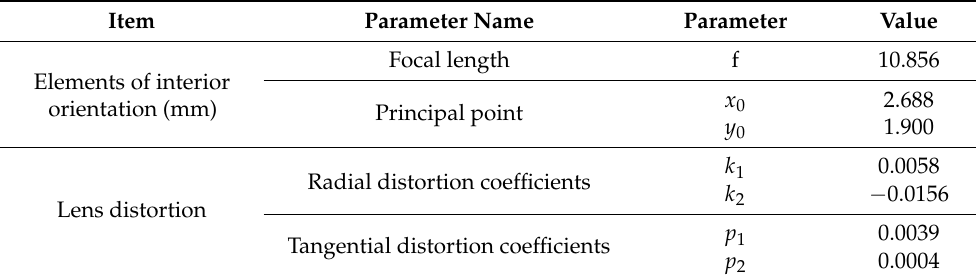
Table 4. Camera elements of the interior orientation and lens distortion calculation